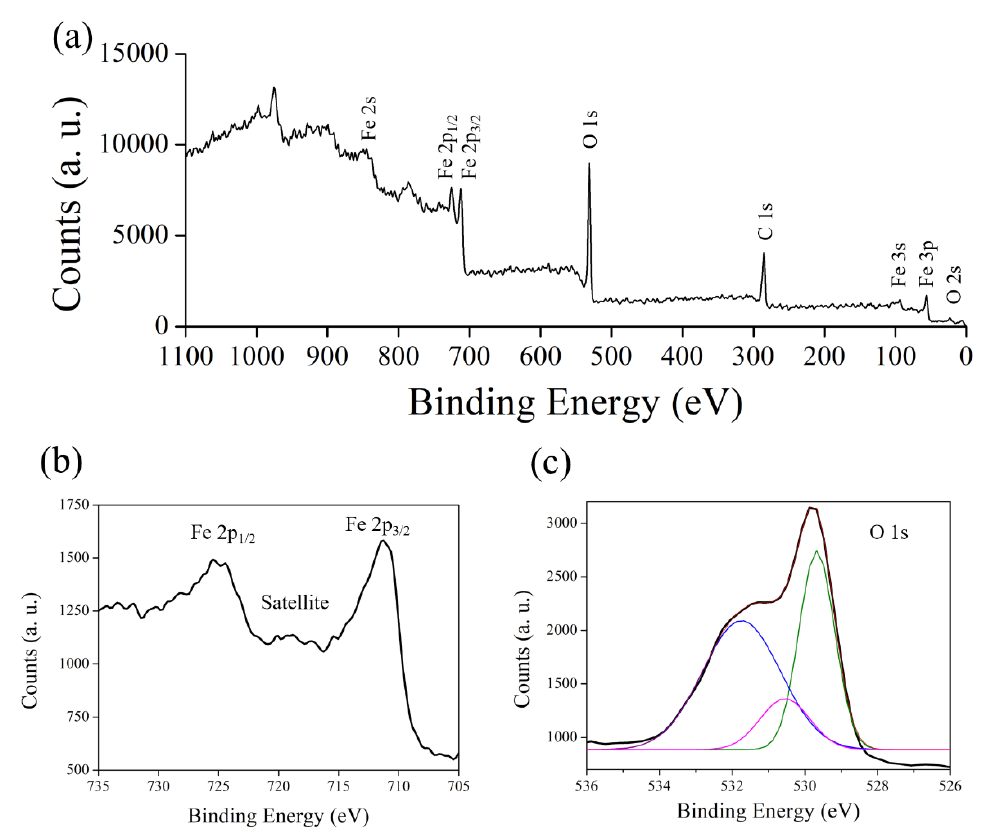
Figure 4. XPS patterns of PLIP-synthesized magnetic Fe 3 O 4 NPs showing ( a ) full spectrum, ( b ) Fe 2p, and ( c ) O 1s.